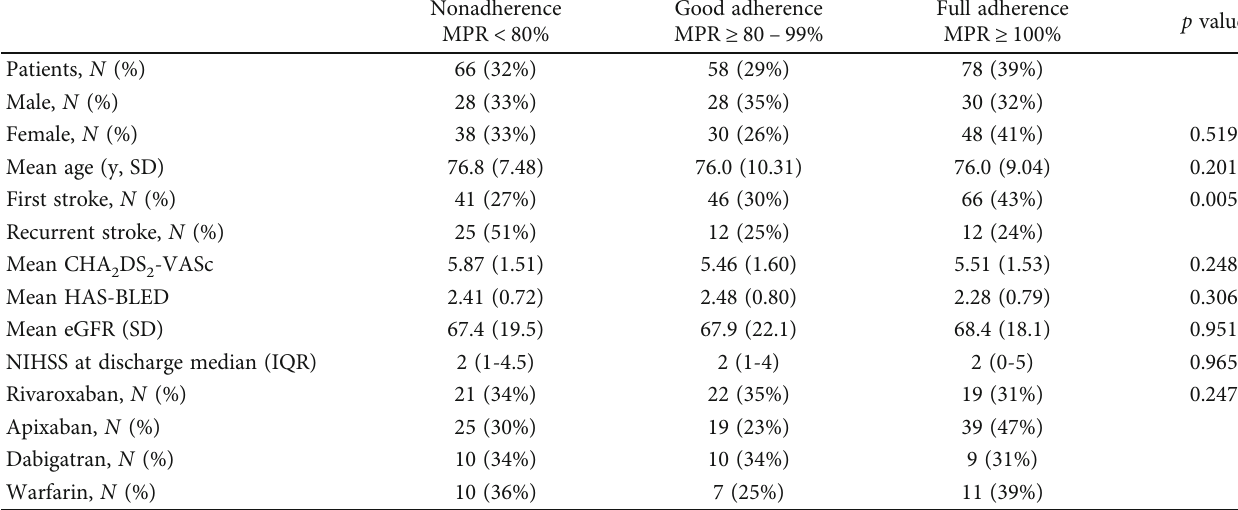
Table 1: Patient characteristics comparing nonadherent patients, patients with good adherence, and patients with full adherence ( N = 202 ).